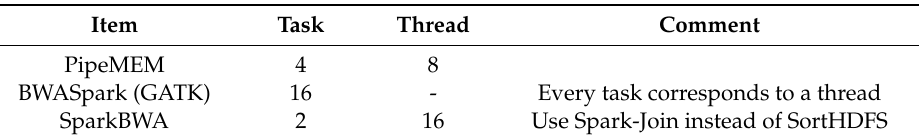
Table 3. Parameter